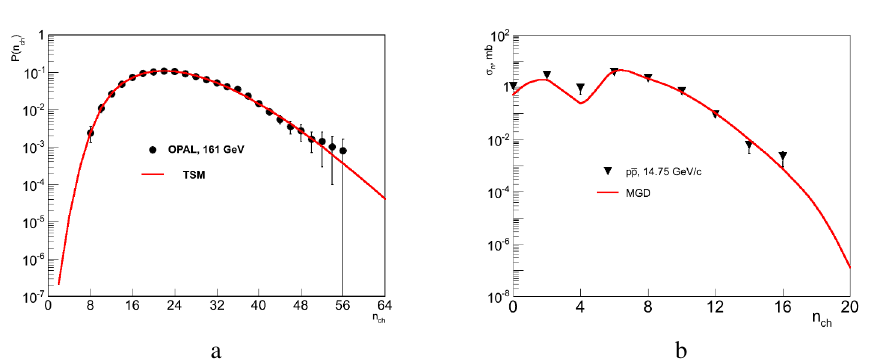
Figure 2. (a) Description of MD of hadron in e + e − annihilation at 161 GeV [9] by GDM [6]. (b) Di ff erences of topological cross sections between proton-antiproton and proton-proton ( σ n = σ pp - σ pp ) interactions at the same energy about ten GeV